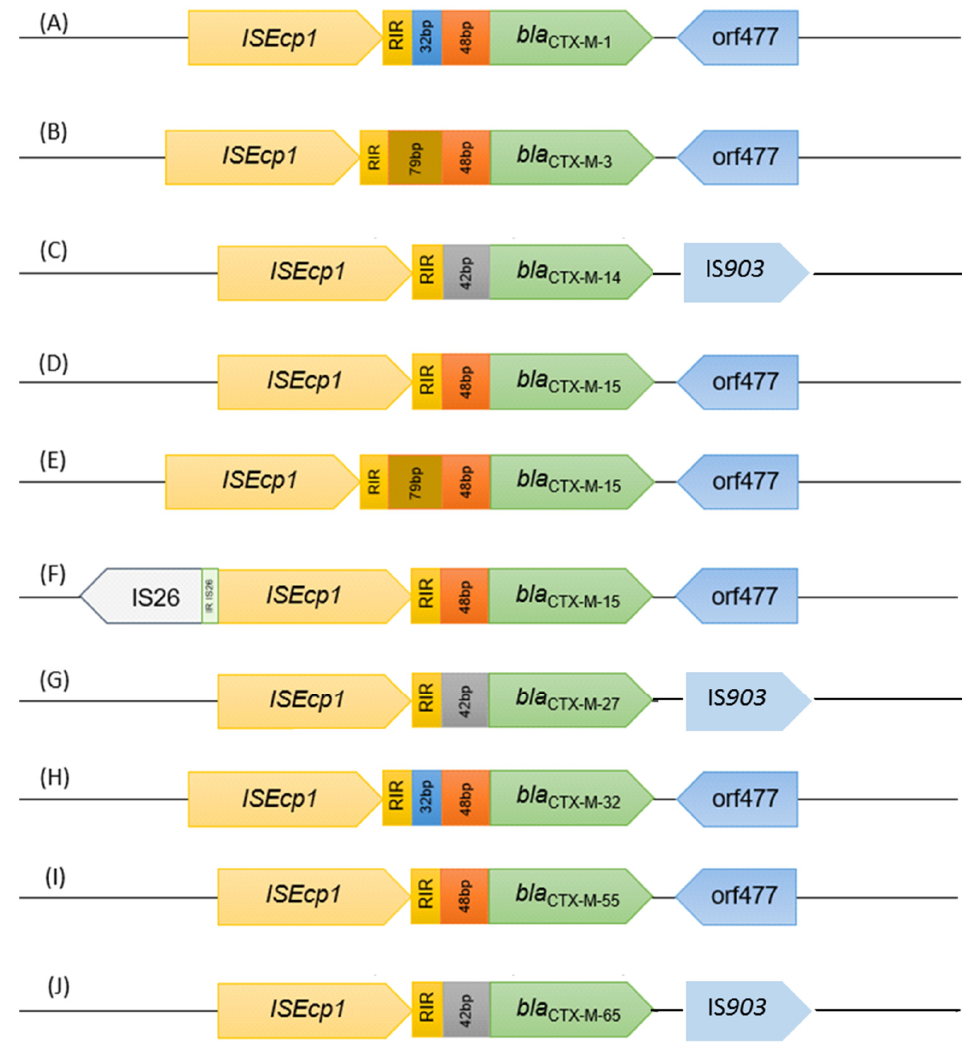
Figure 4. Genomic environments for the variants of the bla CTX-M gene found in the isolates. Ten different environments were observed, and they are represented from ( A ) to ( J ).